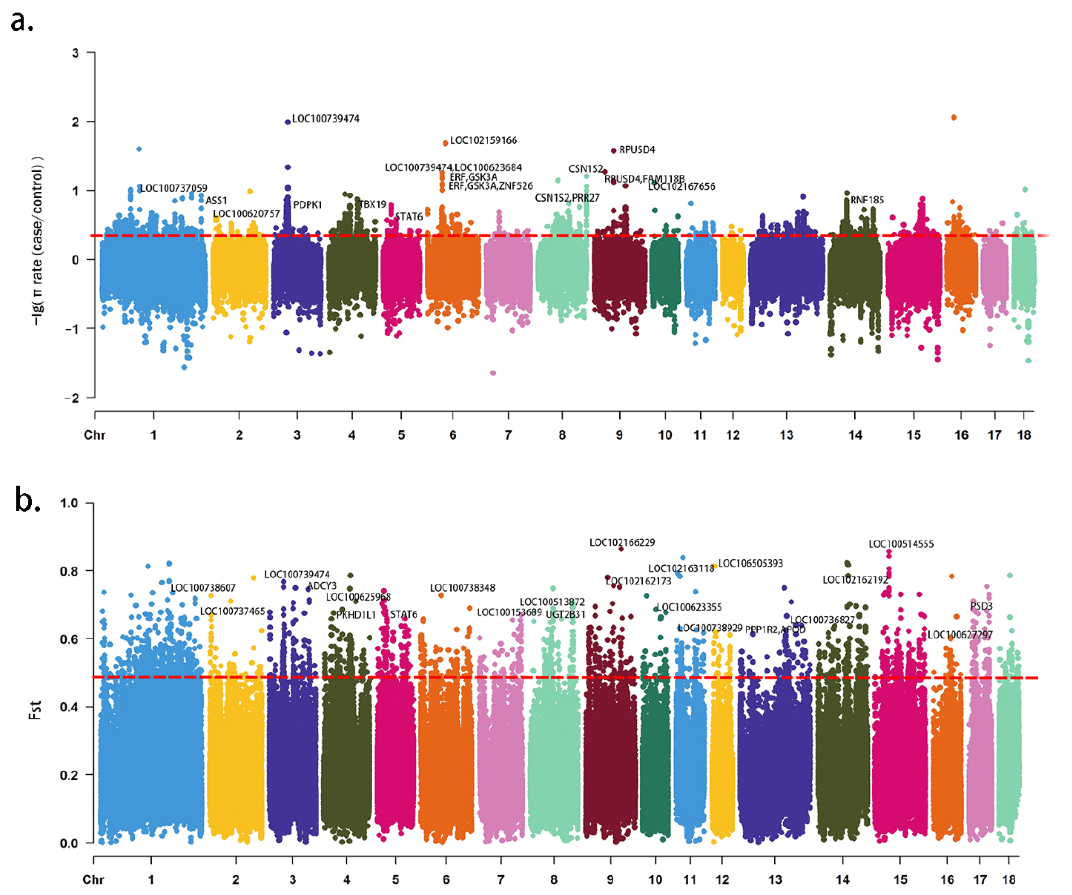
Figure 1. Wide-genome selective signal analysis of 174 pigs by SNP dataset. ( a ) The distribution of θπ ratio ( − Log10[ θπ ratio( θπ case/ θπ control)]) on the autosomal chromosome calculated by 40k sliding window size with 20k step. ( b ) The distribution of F ST on the autosomal chromosomes calculated by 40k sliding window size with 20k step.